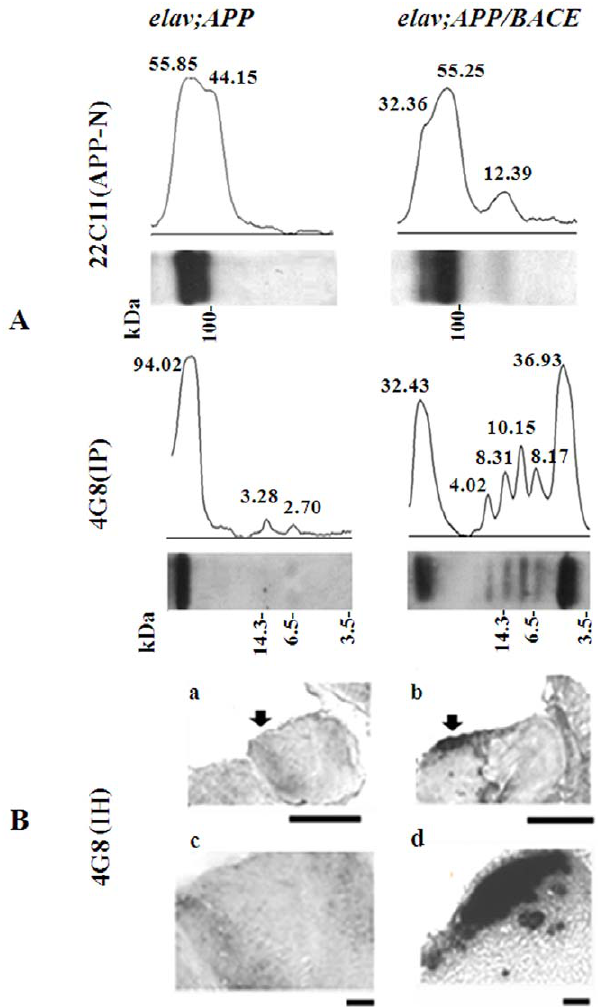
Figure 1. Human APP expression in the brain of transgenic Drosophila . A ) Western blot analysis of APP and A b : 22C11 (APP-N): Full size human APP was detected by monoclonal antibody 22C11 (APP N terminal-specific); 4G8 (IP): A b was immunoprecipitated using anti-A b monoclonal 4G8 antibody; elav;APP; and -elav;APP/BACE- genotypes of transgenic strains used for analysis. All blots were scanned and relative intensity of bands was quantified using Image J software. B ) A b deposits in Drosophila brain: 4G8 (IH): Immunohistochemistry with 4G8 antibody; Arrows indicate areas for magnification. Bar, 50 m m (a, b); Bar, 10 m m (c,